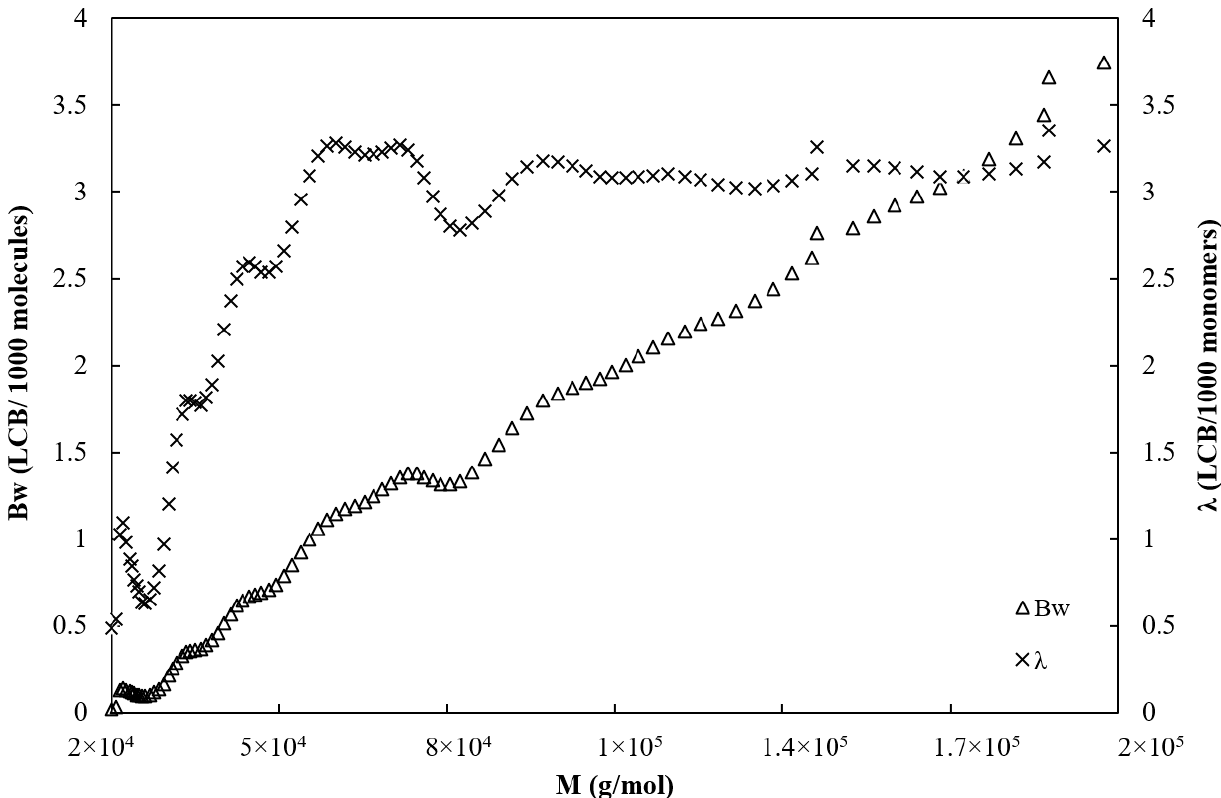
Figure 4. Average number of branch points per molecule B w ( Δ ) and long-chain branched (LCB) frequency per 1000 monomer units λ (×) for BPBS.